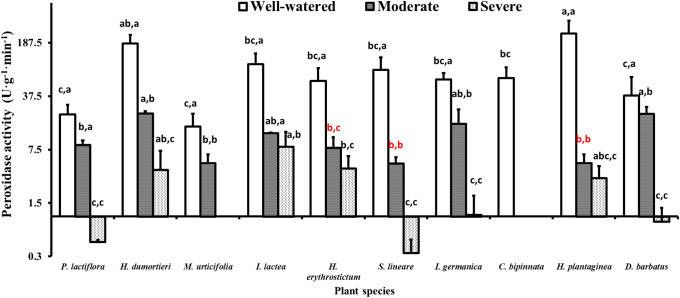
Variance of peroxidase activity of the ten species under the drought stress tests.The histogram shows the mean values. Above the histogram, the lowercase letters before the commas indicate statistical significance among the different plant species, and the lowercase letters after the commas indicate statistical significance among the well-watered, moderate and severe drought stress treatments. The different lowercase letters indicate a significant difference at P<0.05.